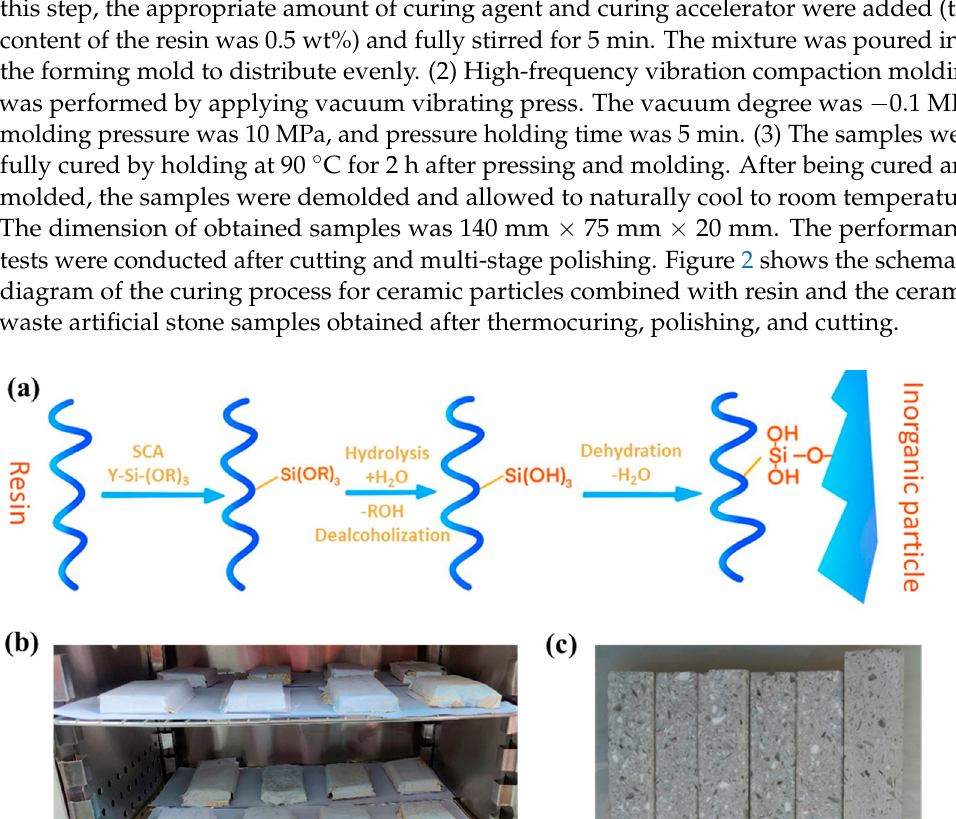
Table 2. Batching of Group B samples with ceramic waste particles instead of quartz sand of differ- ent sizes (in mass fraction).